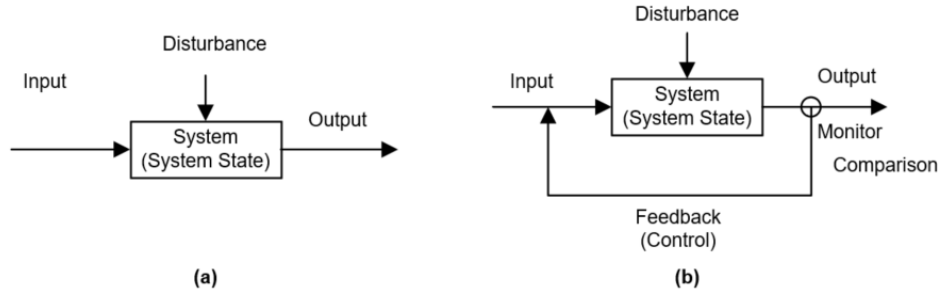
Figure 5. Flow of information for: ( a ) open-loop and ( b ) closed-loop representation of a dynamic system. Source: adapted from Carmichael [44].